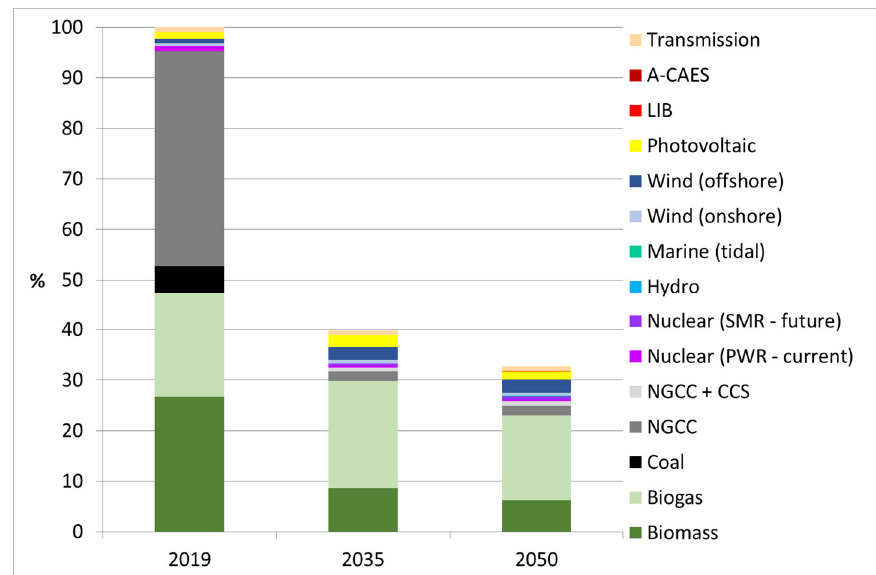
Figure 7. Global warming potential (including biogenic carbon) per unit of electricity delivered by the UK grid mix (including energy storage and transmission), expressed as relative to the 2019 value (100% = 269 g CO 2 -eq/kWh). Energies 2020 , 13 , x FOR PEER REVIEW